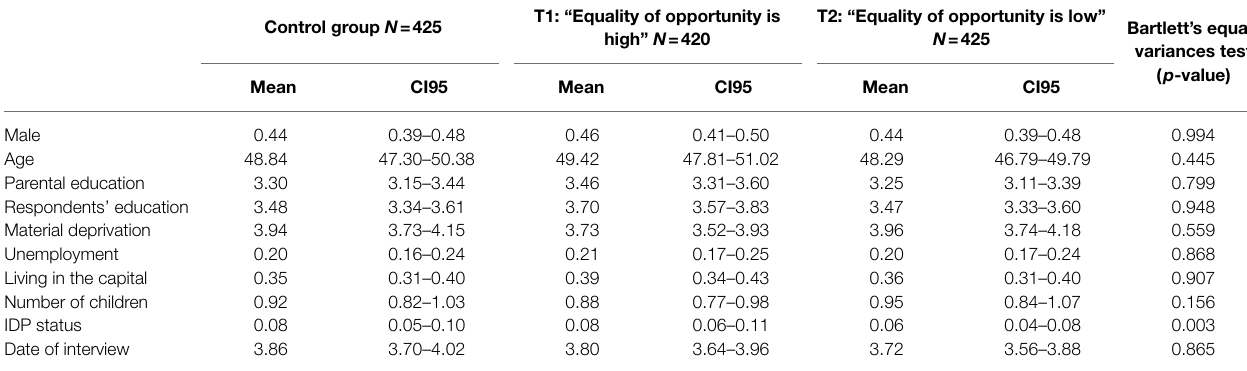
TABLE 1 | Descriptive statistics and the test of significant differences between treatment and control groups. Control group N =